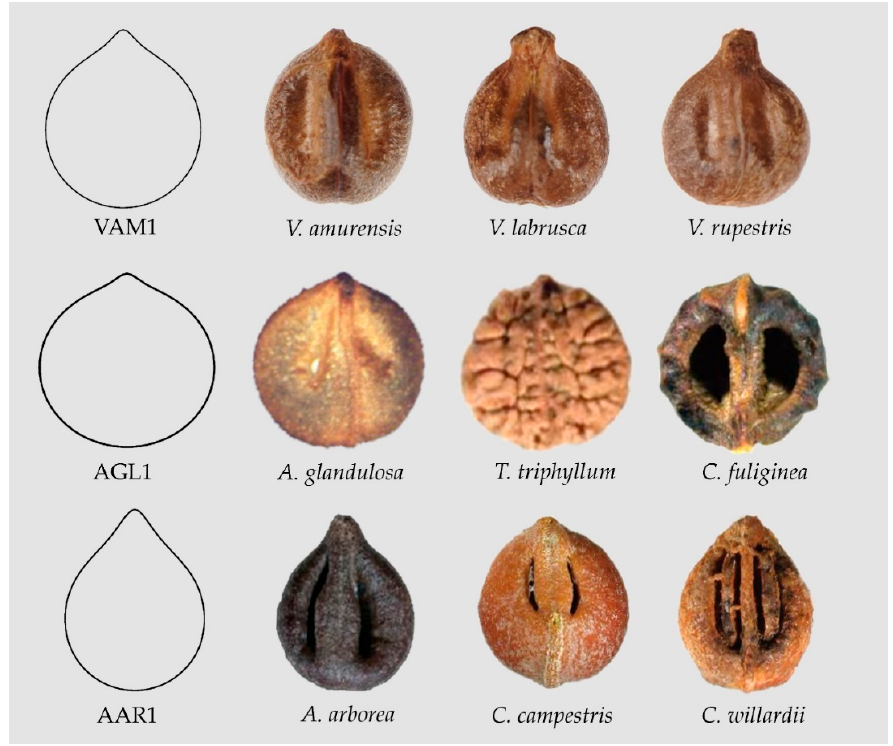
Figure 4. Seed images resembling water drops. From top to bottom: Model VAM1 ( Vitis amurensis , V. labrusca, V. rupestris ), Model AGL1 ( Ampelopsis glandulosa , Tetrastigma triphyllum , Cissus fuliginea ), Model AAR1 ( Ampelopsis arborea , Cissus campestris , C. willardii ).